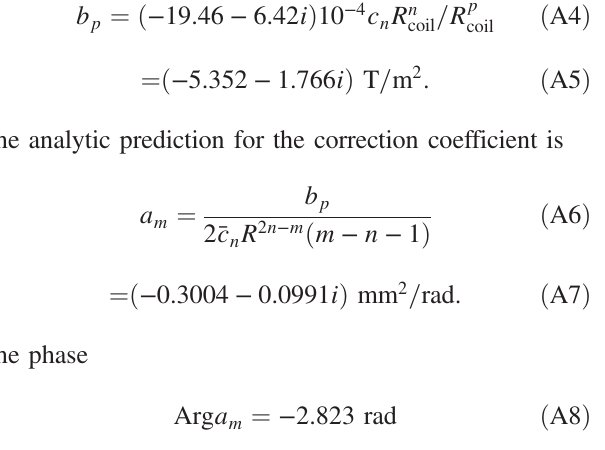
FIG. 16. Fraction of each magnet type completed over